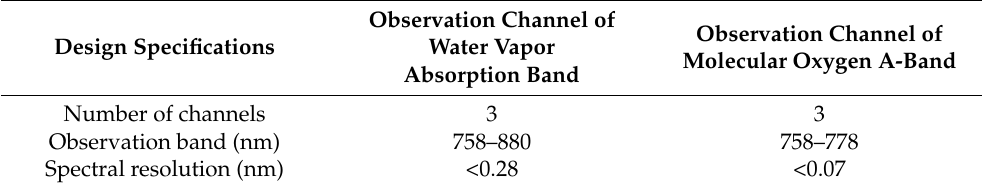
Table 1. Comparison of the design parameters of observation channel between water vapor absorp- tion band and molecular oxygen A-band.